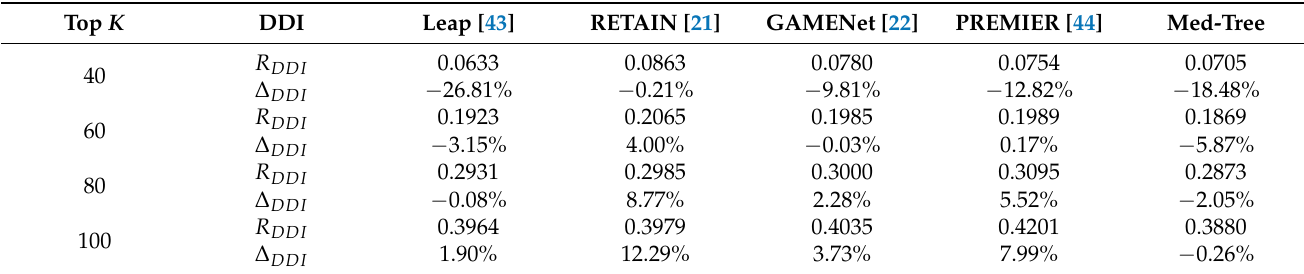
Table 5. The comparisons of the DDI rate between Med-tree and baselines are divided into Top 40, Top 60, Top 80, and Top 100